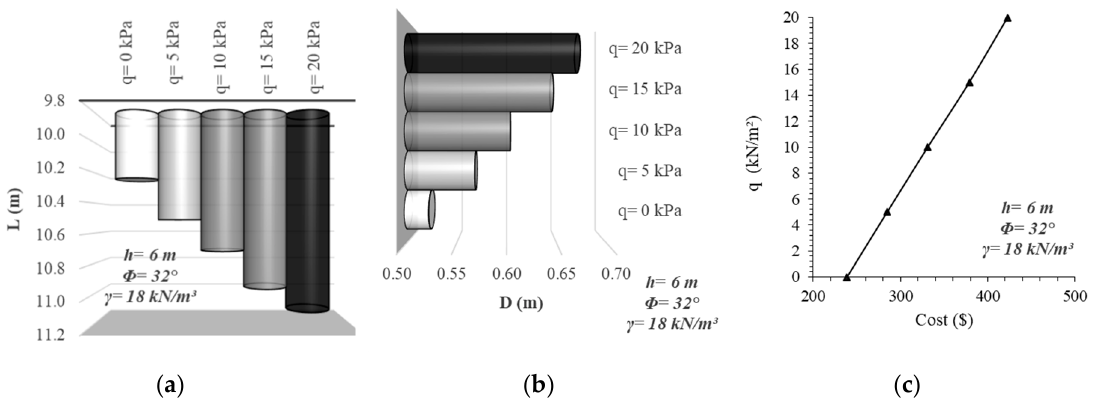
Figure 10. The effects of the change of external load to the diameter of cantilever soldier pile ( a ), the length ( b ), and the unit cost of pile ( c ) (for h = 6 m excavation depth).